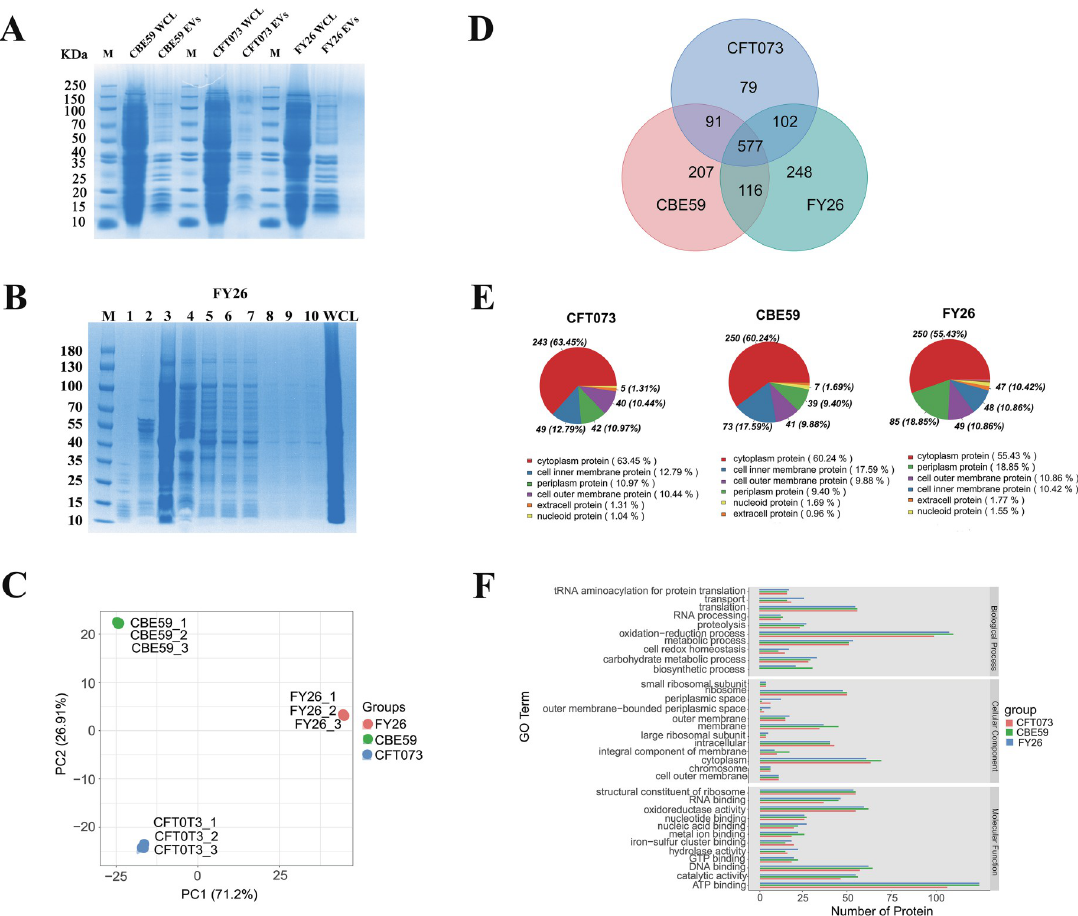
Fig 2. Comparative analysis of total proteins from ExPEC EVs. (A) Density-gradient ultracentrifugation (DGU)-purified EVs of ExPEC strains FY26, CBE59, and CFT073 were analyzed with SDS-PAGE. Total protein (5 μ g) from EVs or 15 μ g of total protein from whole-cell lysates (WCLs) was loaded into the lanes. Lane M: protein marker. (B) ExPEC EVs from different density gradient fractions were analyzed with SDS-PAGE. Fractions (15 μ L loaded onto the gel) are numbered according to increasing density. The images show one representative experiment. M: Protein marker; WCL: 5 μ g loaded into each well of the gel. (C) Principal components analysis (PCA) of the EV proteomes of the ExPEC strains. The graph shows three cluster patterns with overlapping features for CFT073 (red cluster), CBE59 (green cluster), and FY26 (blue cluster). (D) Comparison of EV protein profiles in different ExPEC strains with a Venn diagram. Venn diagram indicates the numbers of identified proteins in the EVs of the three ExPEC strains. (E) Classification of the EV proteins identified in different ST strains by subcellular location. Subcellular localization of the identified EV proteins was predicted with CELLO (http://cello.life.nctu.edu.tw). (F) Functional classification of EV unigenes identified in the three ExPEC strains was determined with Gene Ontology (GO). The GO enrichment analysis identified three categories: cellular component, molecular function, and biological process.